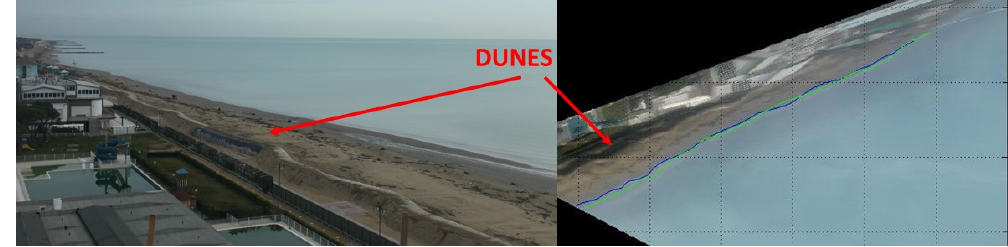
Figure 16. Artificial dunes, during the 9th storm, 30 December 2013, on a timex image and on a rectified image. Table 2. Power law fit (cid:49)x = aY b for storms classified based on wind direction and presence/absence of artificial protections. Protected Not protected Protected + non protected ita WaveEn StormPow StormEn H m WaveEn StormPow StormEn H m